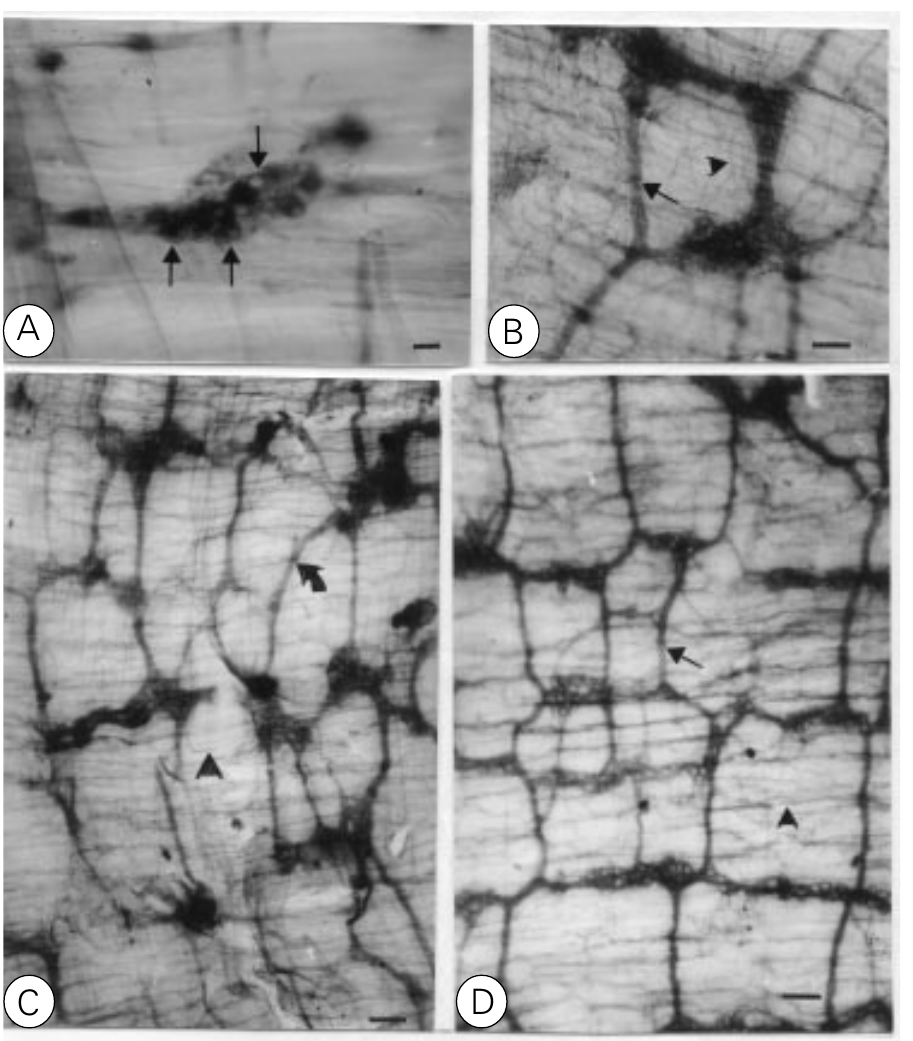
Figure 2 - Stretch preparation from the muscle layer of the esophagus (A), stomach (B), je- junum (C) and colon (D) showing the myenteric plexus. Cholines- terase method. A , Intensely stained neurons (arrows). B-D , The plexus consists of a primary meshwork of thick nerve bundles (arrows) and a secondary mesh- work of finer bundles (arrow- heads). In the primary mesh- work, the nerve cell bodies oc- cur mainly at the nodes of the plexus. Note the variable inten- sity of nerve cell staining. Scale bars = 40 (cid:181)m.